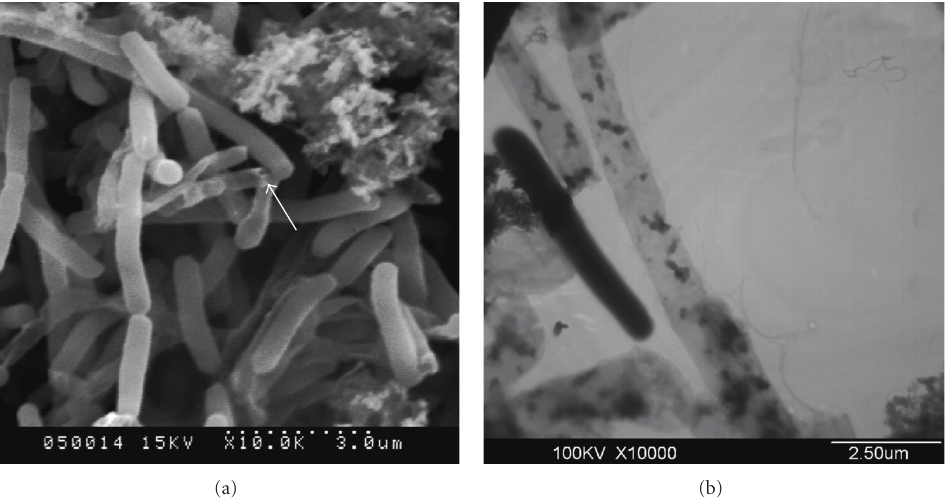
Figure 3: Electron microscopy analyses of F. columnare G4cpN22 ghosts. (a) Arrow showed the transmembrane lysis tunnel located mainly at the cell poles via SEM. (b) Loss of cytoplasmic materials of F. columnare G4cpN22 ghosts was shown by TEM. The lysed cells showed uneven and low electron density and retained the basic cell morphology of the bacterial cells, while the unlysed cells showed even and high electron density in an integral cell structure.